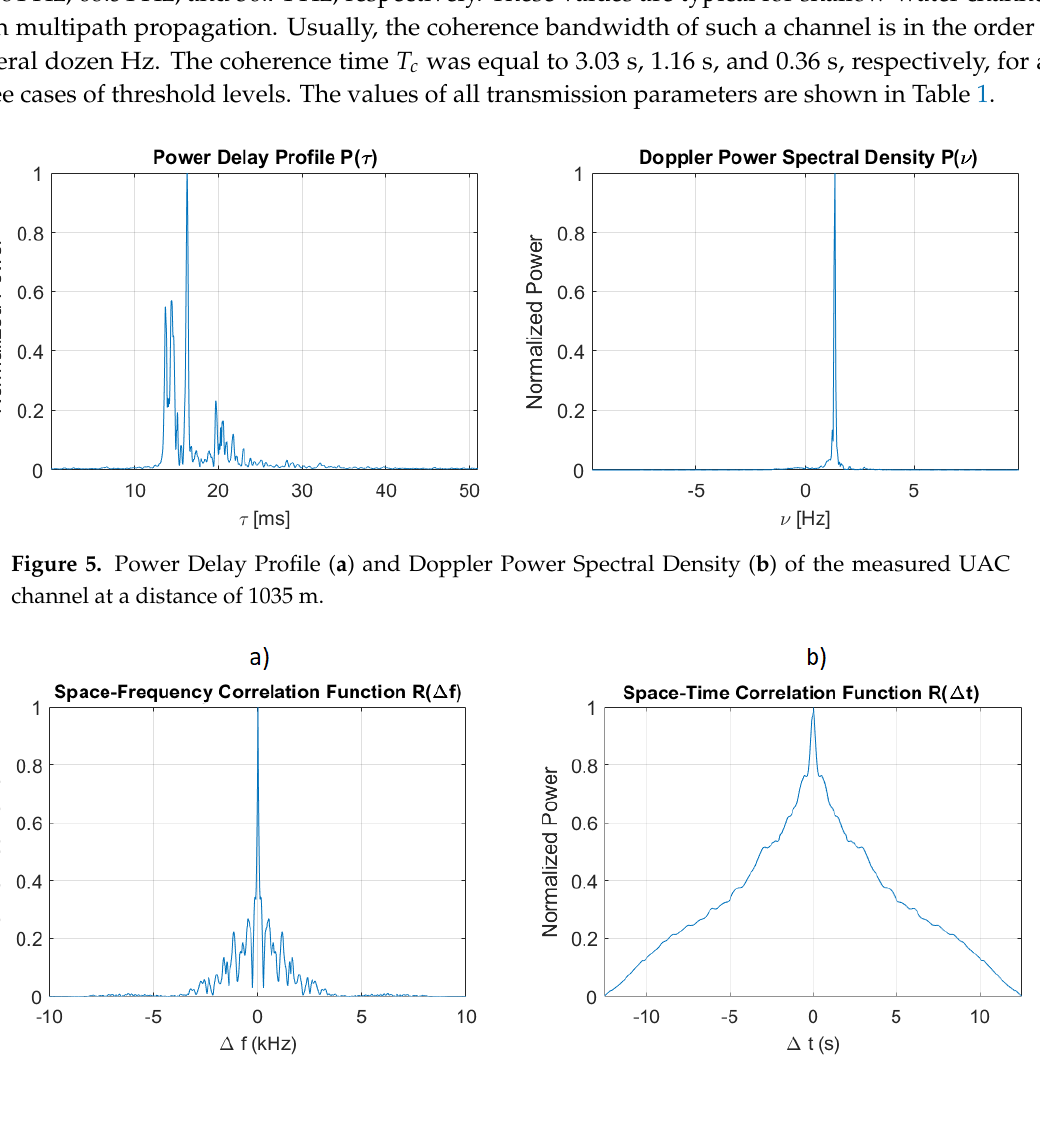
Figure 6. Space-frequency Correlation Function ( a ) and Space-Time Correlation Function ( b ) of the measured UAC channel at a distance of 1035 m. Table 1. Transmission parameters of the measured UAC channel at a distance of 1035